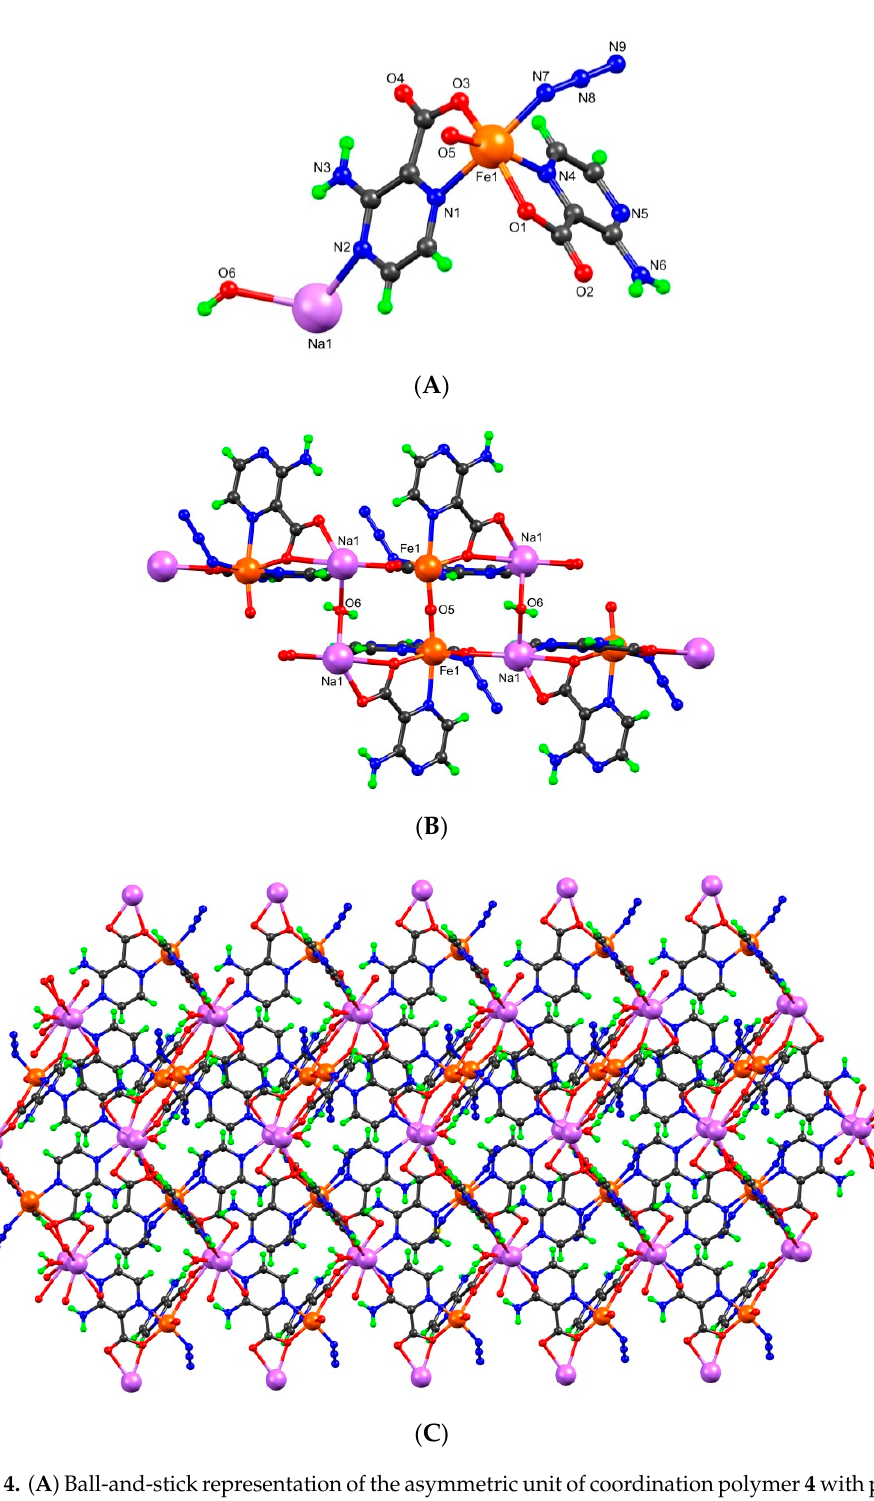
Figure 4. ( A ) Ball-and-stick representation of the asymmetric unit of coordination polymer 4 with partial atom numbering scheme, ( B ) its crystal structure, and ( C ) two-dimensional depiction (arbitrary view).